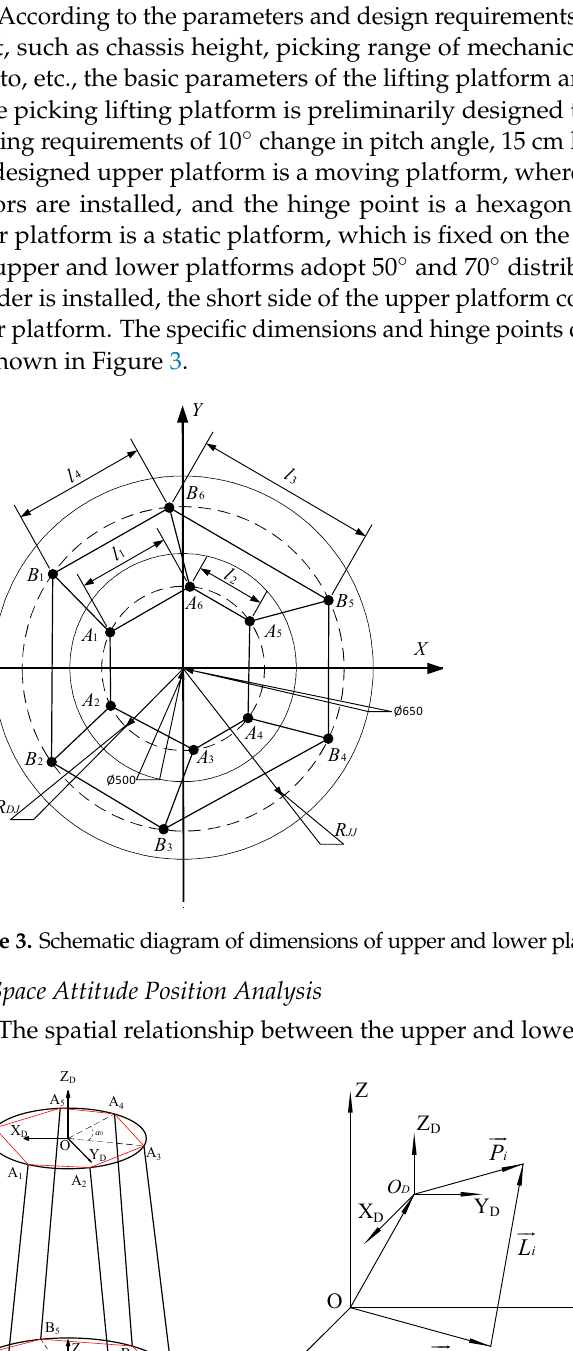
Figure 2. Schematic diagram of chassis structure and working range of picking robot. (1, Chassis mobile platform; 2, Lifting platform; 3, Picking mechanical arm; The red circles represent mature tomatoes, while the green circles represent immature tomatoes). ( a ) Schematic diagram of struc- ture and size of picking robot chassis. ( b ) Schematic diagram of picking robot’s working range.